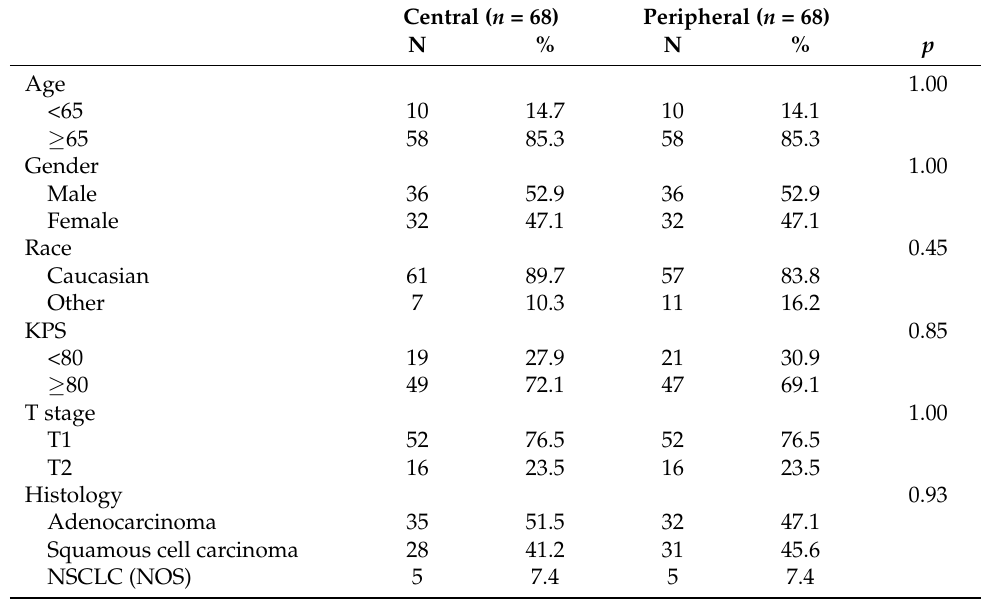
Table 4. Baseline characteristics after propensity score